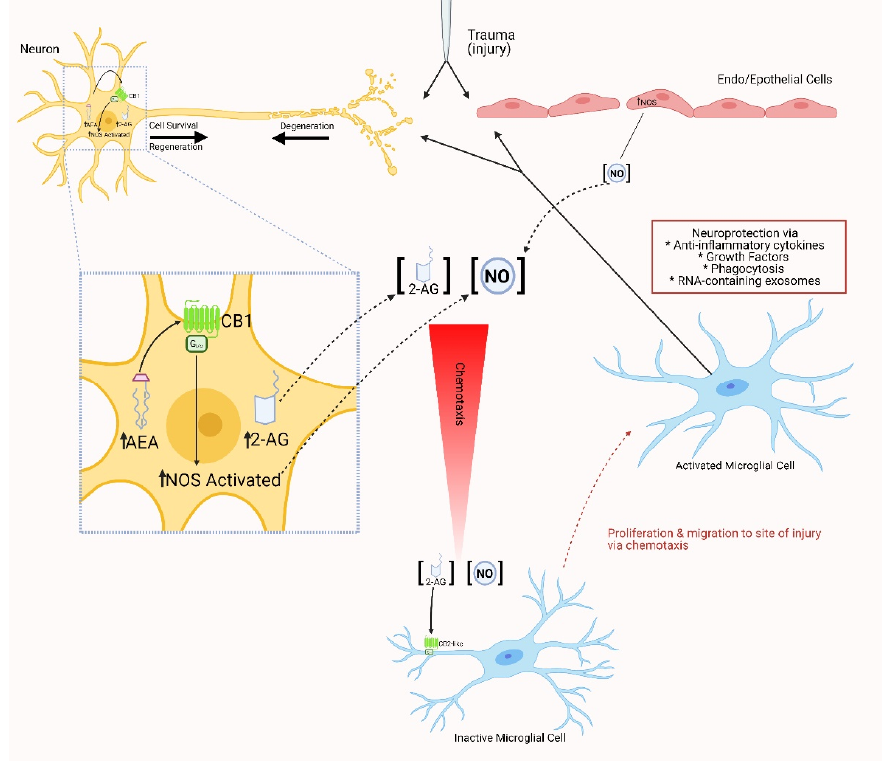
Figure 3. Experimental model summarizing the role of endocannabinoid signaling and nitric oxide production in the activation and chemotaxis of microglia after nervous system injury in the leech. CNS injury elicits an increase in nitric oxide synthase activity in both endo- and epithelial cells, as well as damaged neurons. NO diffuses away from the injury site to promote the concentration-dependent directed movement of activated microglia to the damaged area. At the same time, activation of anabolic enzymes in damaged neurons leads to the increased production of the endocannabinoids AEA and 2-AG. AEA can act in an autocrine manner through CB1-like receptors on neurons to increase the production of NO at the lesion site as well as promote neurite growth. 2-AG, at the same time, acts as a chemoattractant for microglia via CB2-like receptors on the lamellipodia of these immunomodulatory cells. Activated microglia accumulate at the lesion site and provide neuroprotection with the release of anti-inflammatory cytokines, growth factors and RNA-containing exosomes as well as phagocytic activity to clean up cellular debris. (With contributions from [101,102]. [Created with Bio-render, BioRender.com (accessed on 21 January